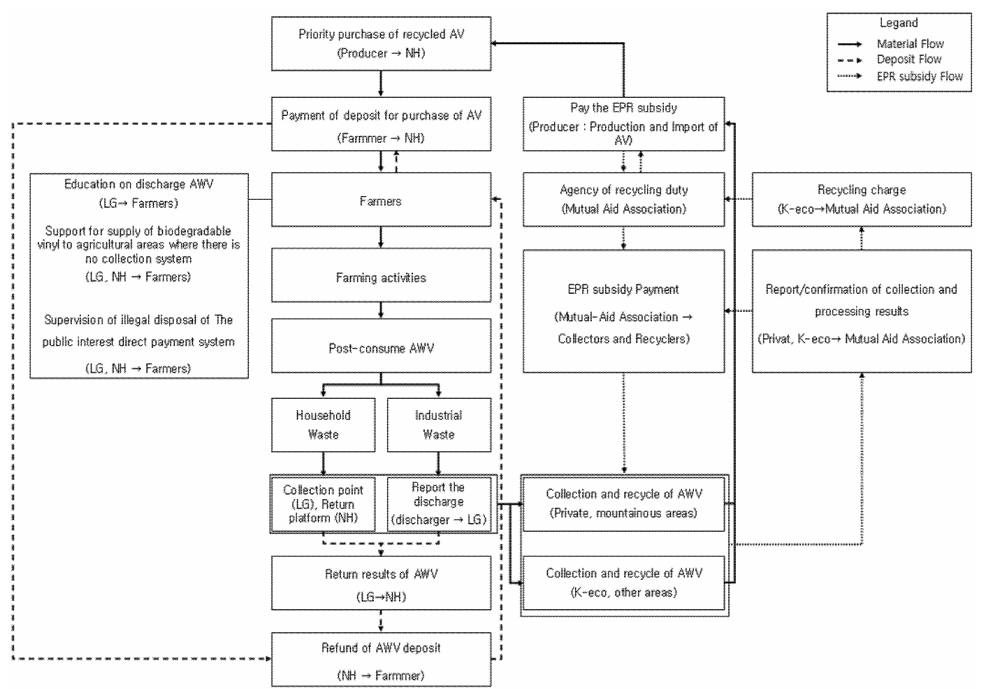
Figure 5. Scheme of suggested sustainable management model of AWV in